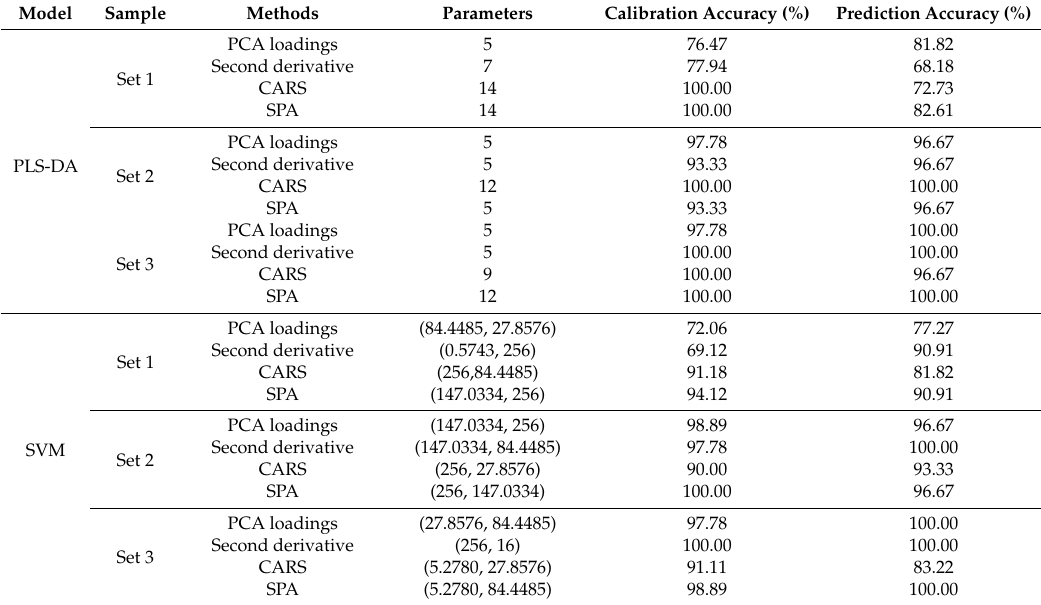
Table 3. The results of PLS-DA and SVM models using optimal wavelengths of three sample sets.